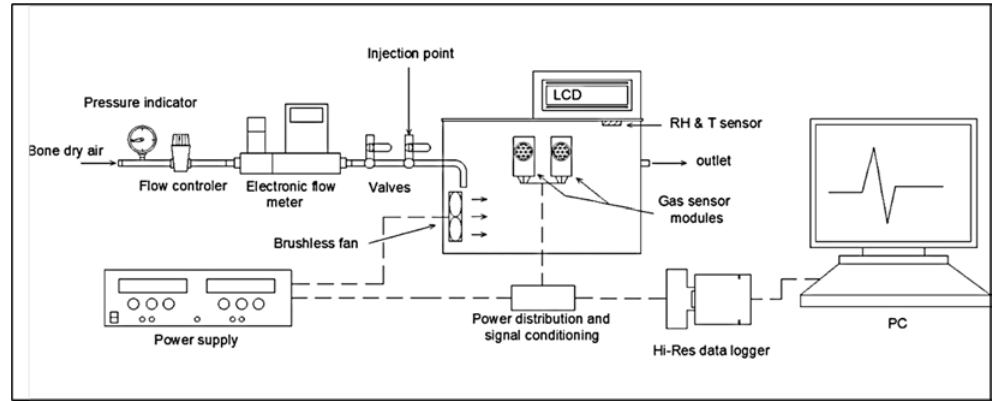
Figure 2. Gas concentration measurement apparatus.